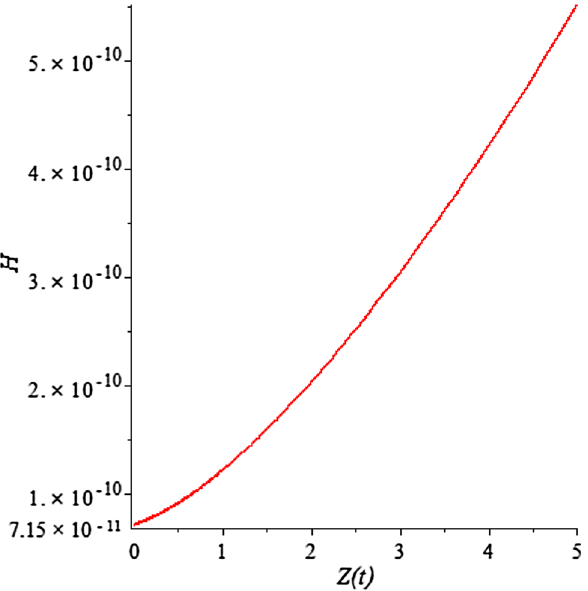
Fig. 3 TheHubbleparameter H versusredshift z plotgivesthepresent value of the Hubble parameter H 0 = 7 . 15 × 10 − 11 year − 1 . This value corresponds to H 0 = 69 . 96 Km s − 1 Mpc − 1